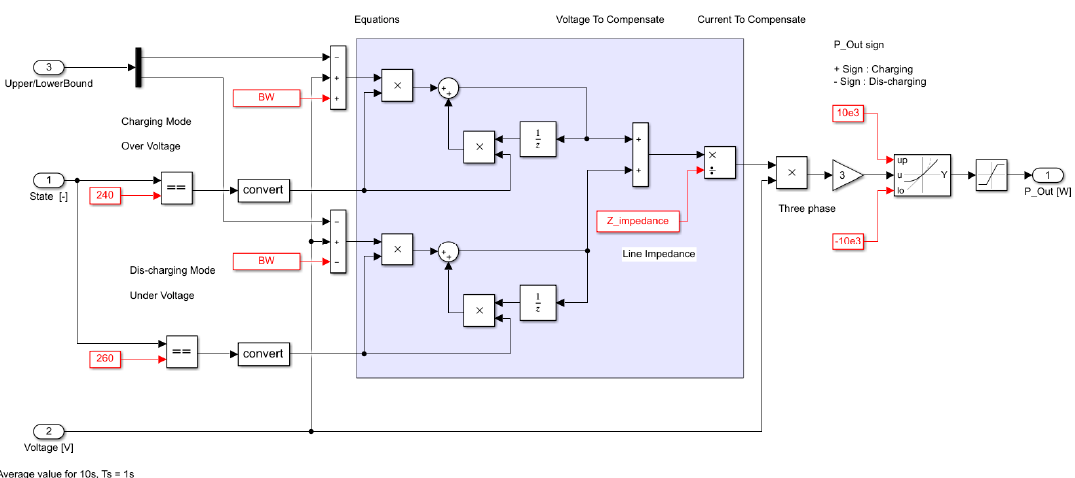
Figure 15. Voltage compensation algorithm in the ‘Grid Support’